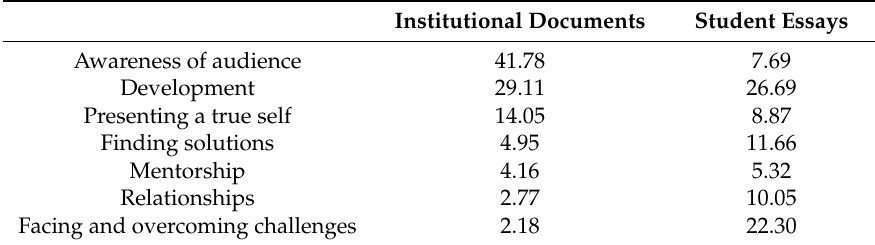
Table 3. Percent (%) of t-units per major value emphasized across all